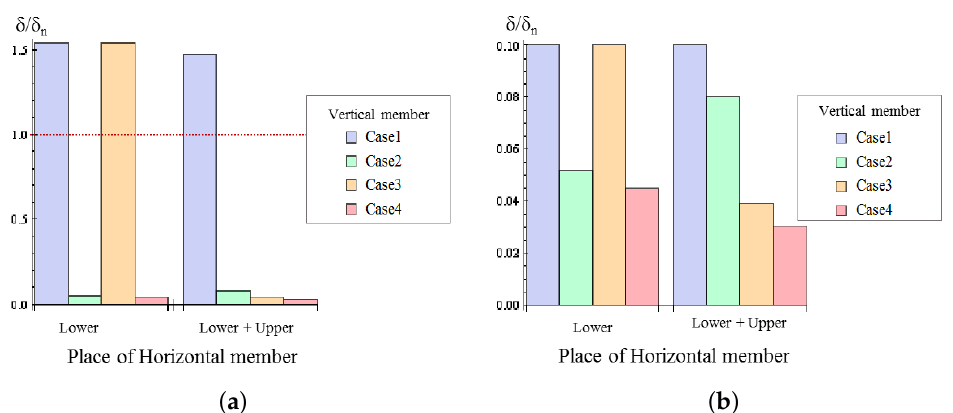
Figure 10. Summarized central displacement in two units model according to the reinforcing layouts: